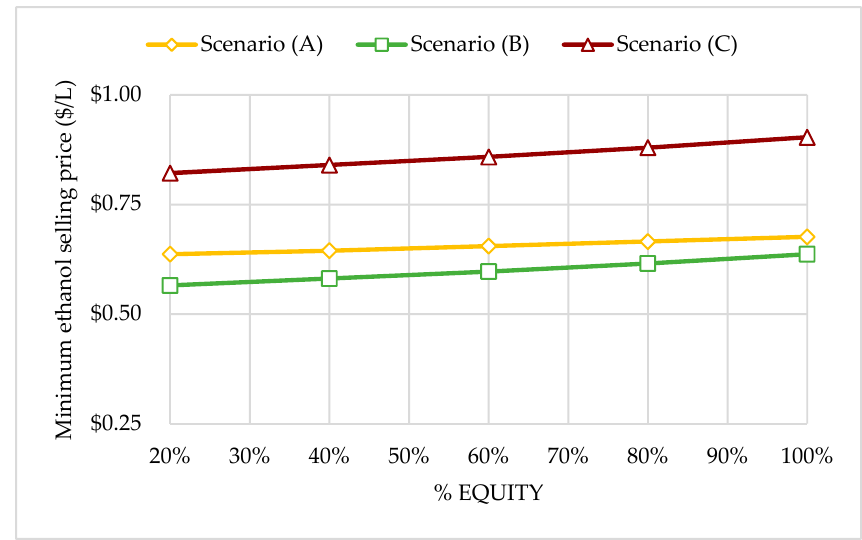
Figure 6. Sensitivity of minimum ethanol selling price (MESP) to IRR (10%) and percent equity (8.25% interest with a 10-year loan) for scenarios A, B, and C.